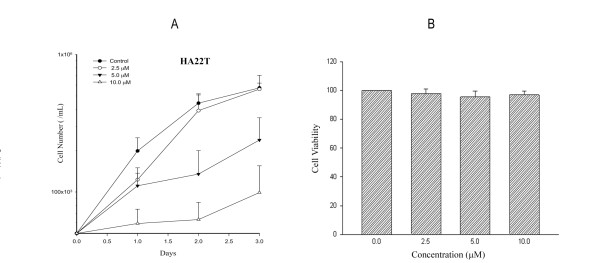
Growth inhibition in hepatoma cells and human normal macrophages treated by costunolide. Cell viability was assessed by trypan blue exclusion test for HA22T/VGH cells and MTT assay for macrophages. A, HA22T/VGH cells. B, Macrophages.